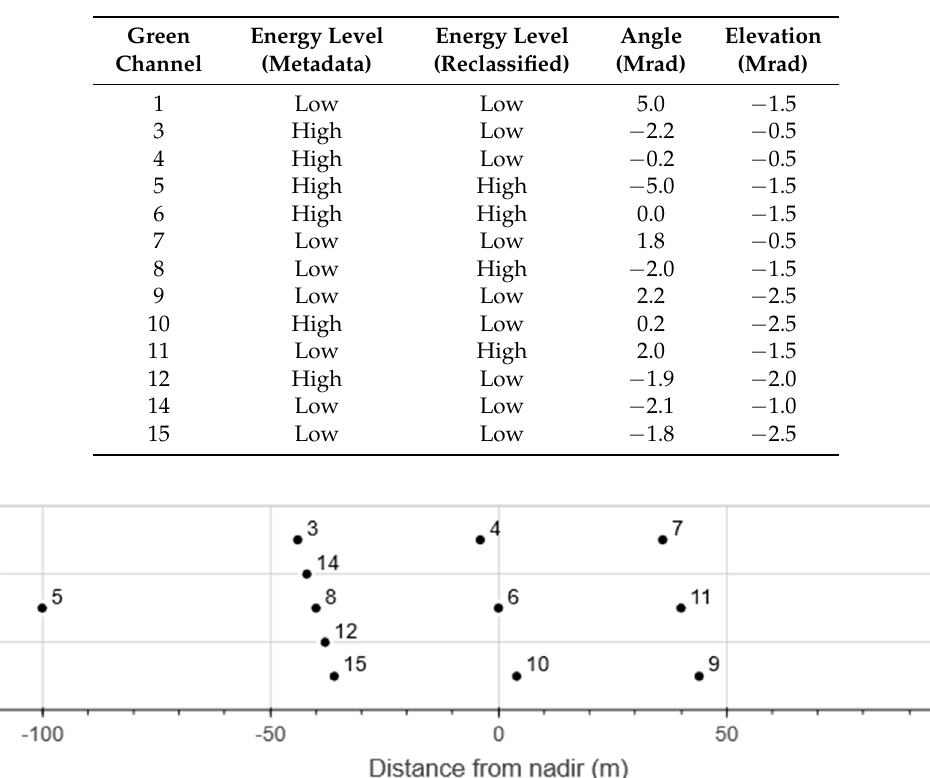
Table 1. MABEL channel specifications for the 13 green channels configured for the “Transmit to KPMD” mission.